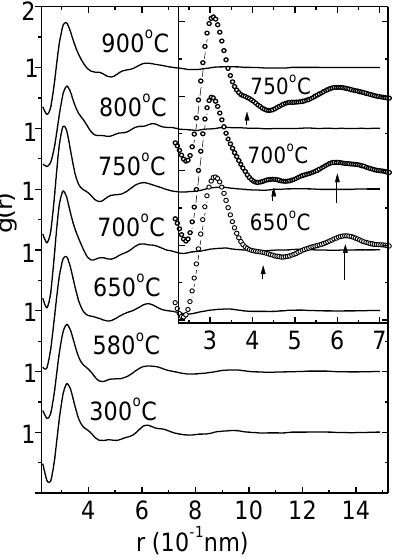
Figure 5. g( r ) patterns of the melt In-Sn80 at each temperature.